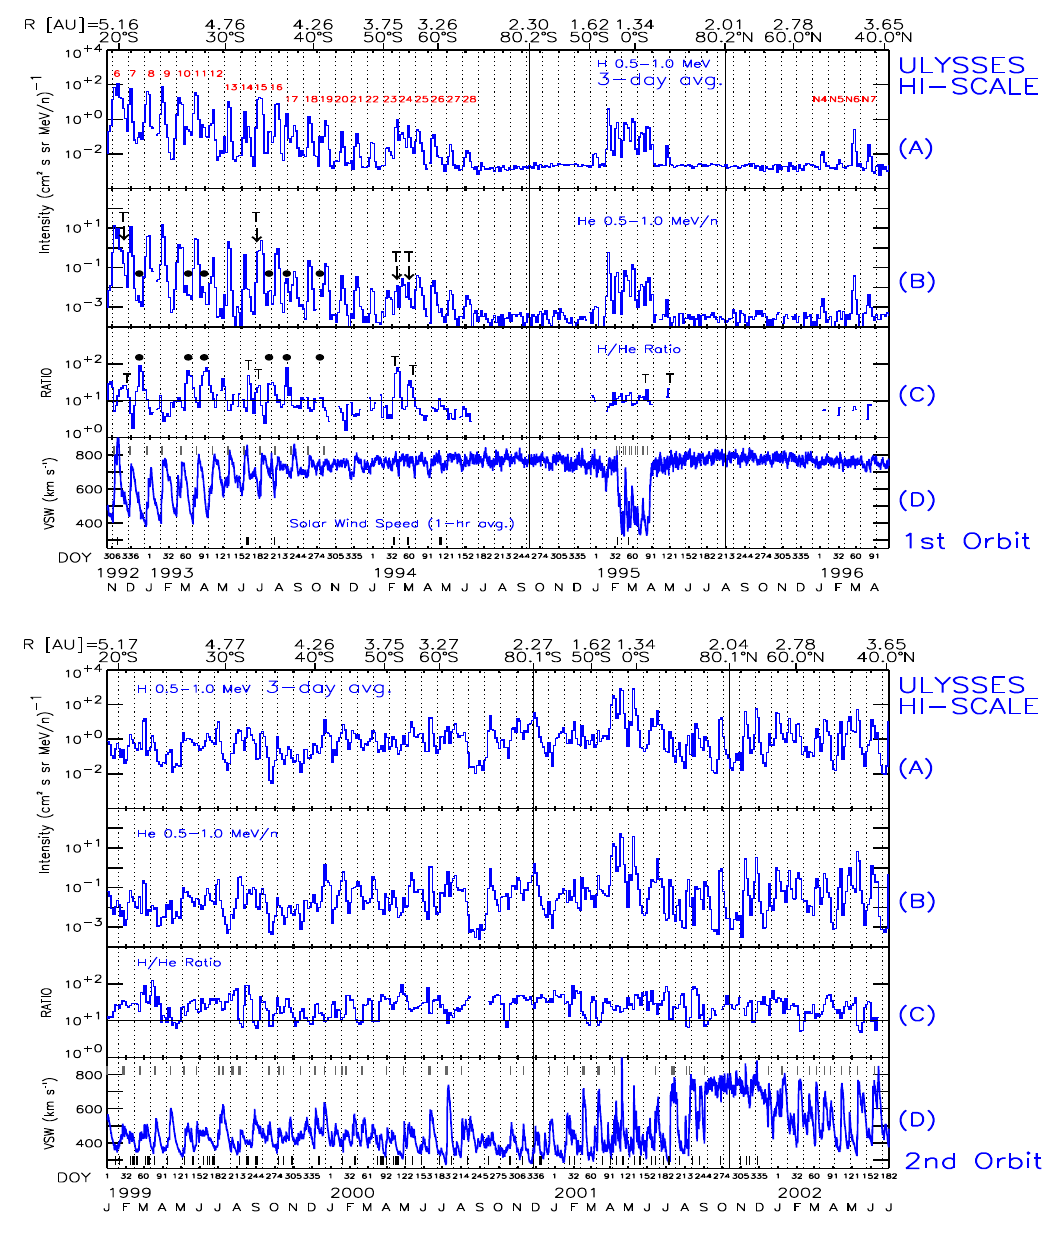
Fig. 1. Three-day averages of the (A) 0.5–1.0MeV proton intensity and (B) 0.5–1.0MeV/nucleon helium intensity as measured by the HI-SCALE instrument (Lanzerotti et al., 1992). (C) H/He ratio calculated from the H and He traces shown in panels (A) and (B). (D) Hourly averages of the solar wind speed as measured by the SWOOPS instrument (Bame et al., 1992). The top set of four panels extends from 24 October 1992 to 23 April 1996 and the bottom set from 1 January 1999 to 1 July 2002. Upper gray rectangles in the solar wind panels (D) show the arrival of compression regions formed by the interaction between solar wind of different speeds; and black rectangles at the bottom of the solar wind panels (D) indicate the intervals associated with the passage of interplanetary counterparts of CMEs as identified by counterstreaming halo electron events in the solar wind (McComas et al., 2000). Note that this identification has only been done up to the end of 2001. The occurrence of transient particle events and “inter-events” are indicated by T s and black dots in the panel (C) (Roelof et al., 1995). The vertical solid lines mark the time when Ulysses reached its maximum southern and northern heliolatitudes. Vertical dotted lines are spaced every 26 days. Rotation numbering scheme in panel (A) of the first graph has been adapted from Bame et al. (1993) and Roelof et al.